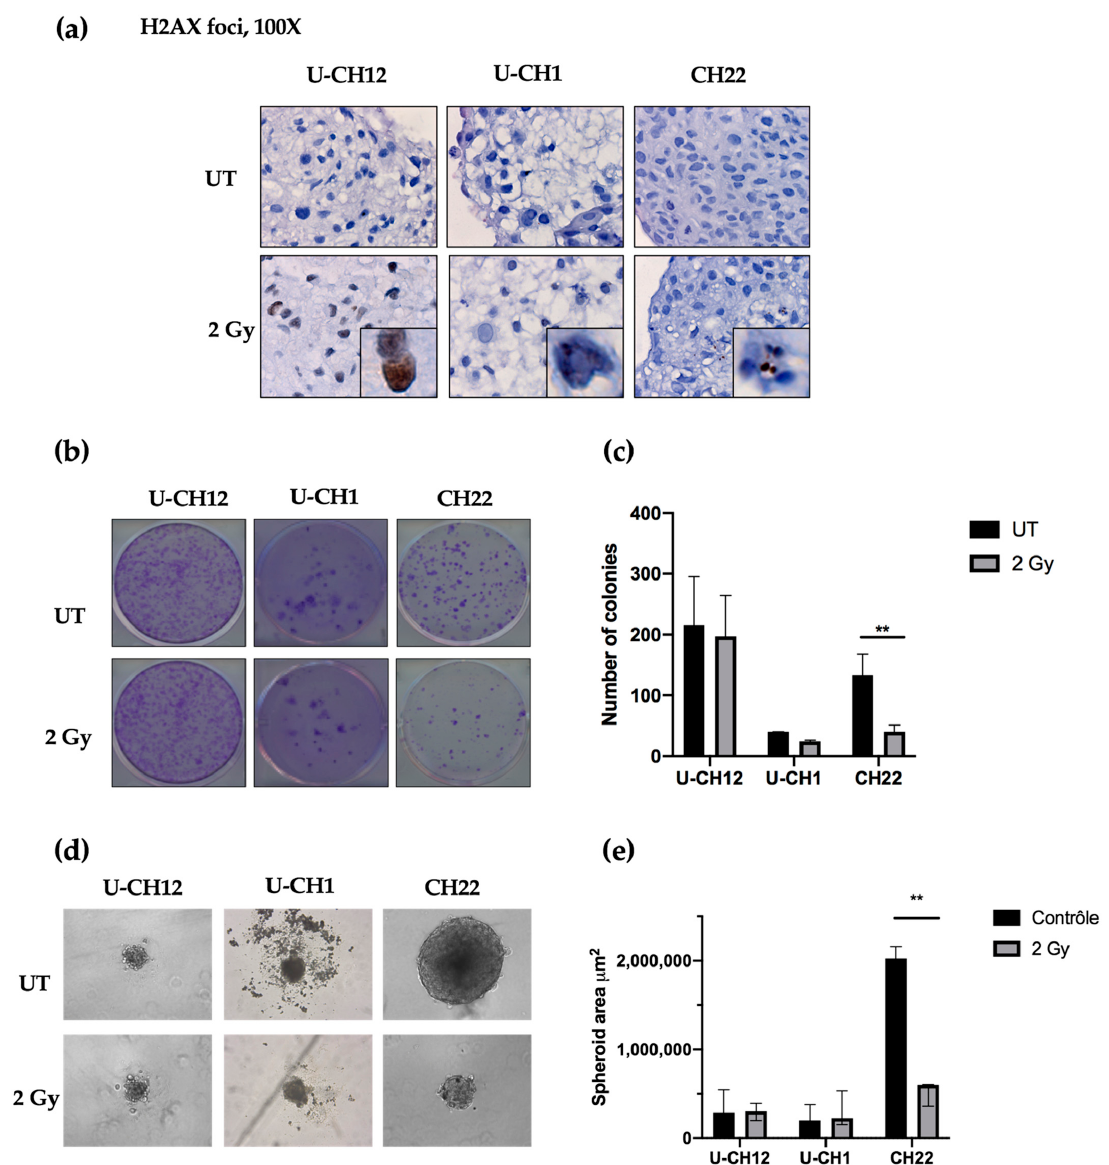
Figure 3. Chordomas exhibit three different levels of radioresistance: ( a ) DNA double-stranded breaks induced by radiation and quantified using γ H2AX foci staining, ( b ) images and ( c ) a graph representative of the number of colonies formed in untreated conditions or after 2 Gy of X-rays, and ( d ) images and ( e ) a graph representative of the spheroid size in untreated conditions or after 2 Gy of X-rays. Each experiment was repeated three times in triplicate. Comparisons between untreated and radiation-treated groups were analyzed with a two-way ANOVA. Significant p -values are indicated as follows: p < 0.05 *, p < 0.01 **, p < 0.001 ***, and p < 0.0001 ****.